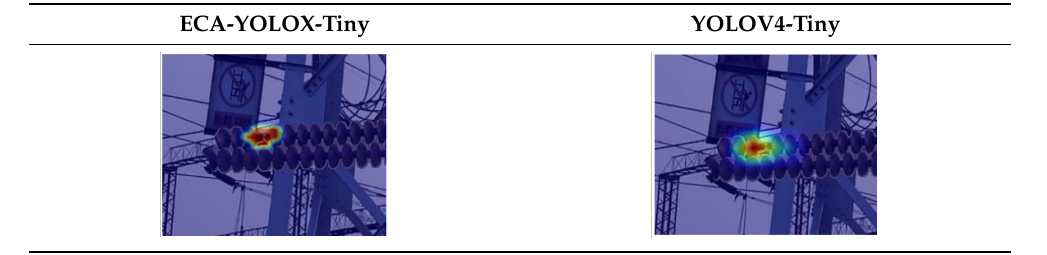
Table 10. The heatmap visualization of different models for defective insulators.